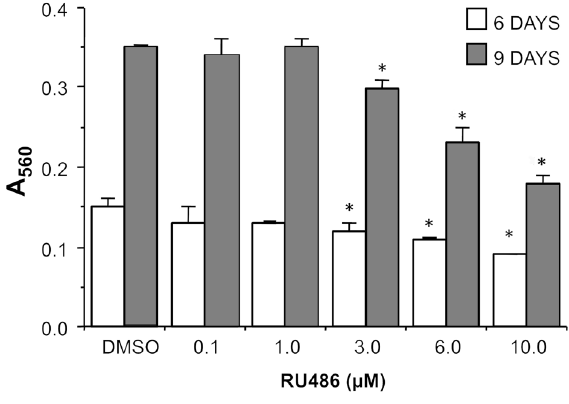
Figure 3. Dose-dependent inhibition of SK-N-SH cell viability after the exposure to RU486 for 6 and 9 days. The results are reported as the mean ± SD of absorbance at 560 nm of three experiments done in triplicate. *P o 0.05 vs DMSO